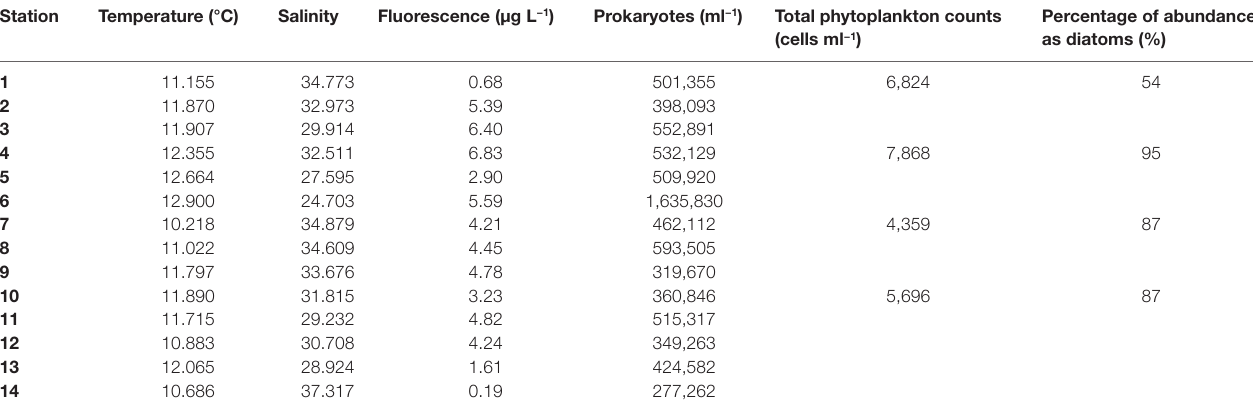
TABLE 1 | Surface values of temperature, salinity, fluorescence levels, total heterotrophic prokaryote abundance (cells ml −1 ), total phytoplankton abundance, and diatom percentage in 2017 in the Northern Adriatic Sea. Station